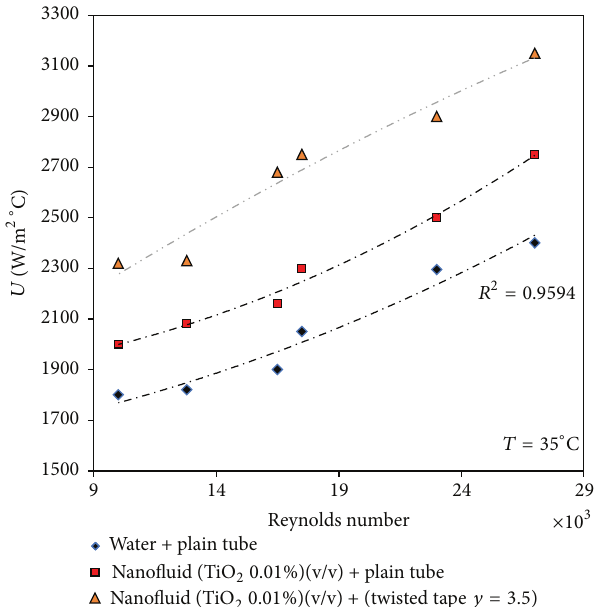
Figure7:VariationofoverallheattransfercoefficientwithReynolds number.